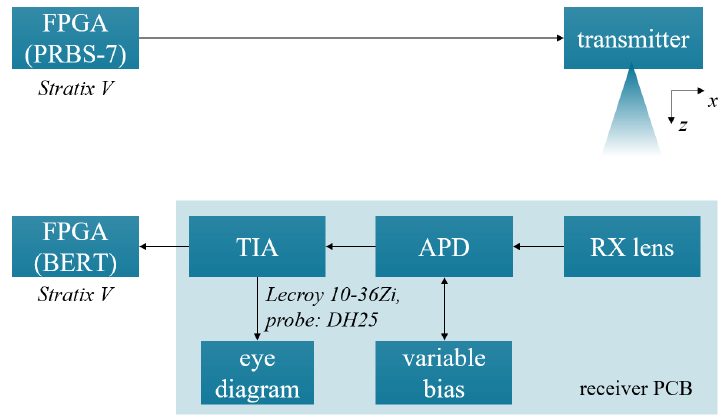
Figure 5. ( a ) Measured photocurrent I PD with and without the TIR lens. ( b ) Measured and simulated concentration ratio g o .